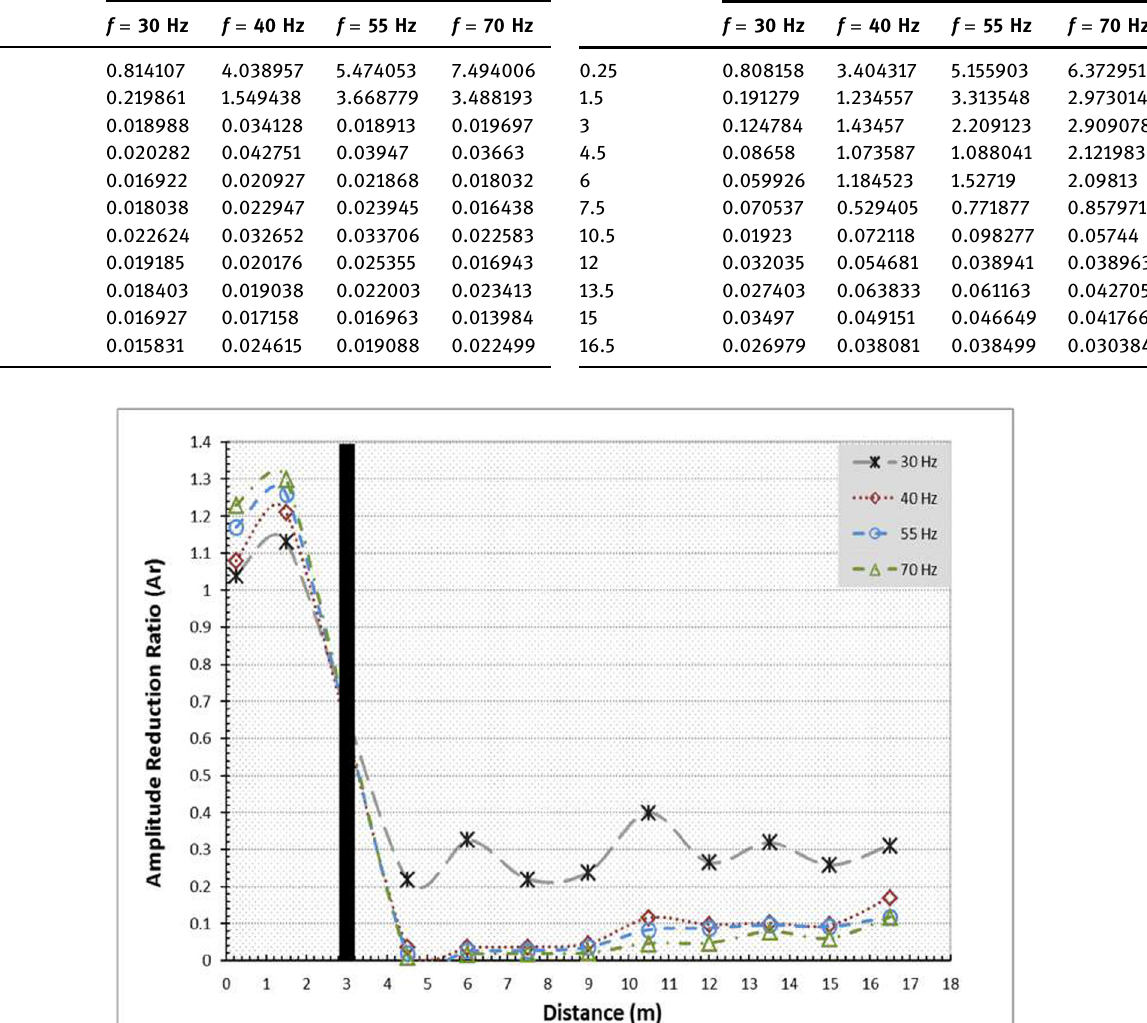
Table 5: The measured peak particle velocities at di ff erent locations for various frequencies ( active open trench barrier ) Distance ( m )